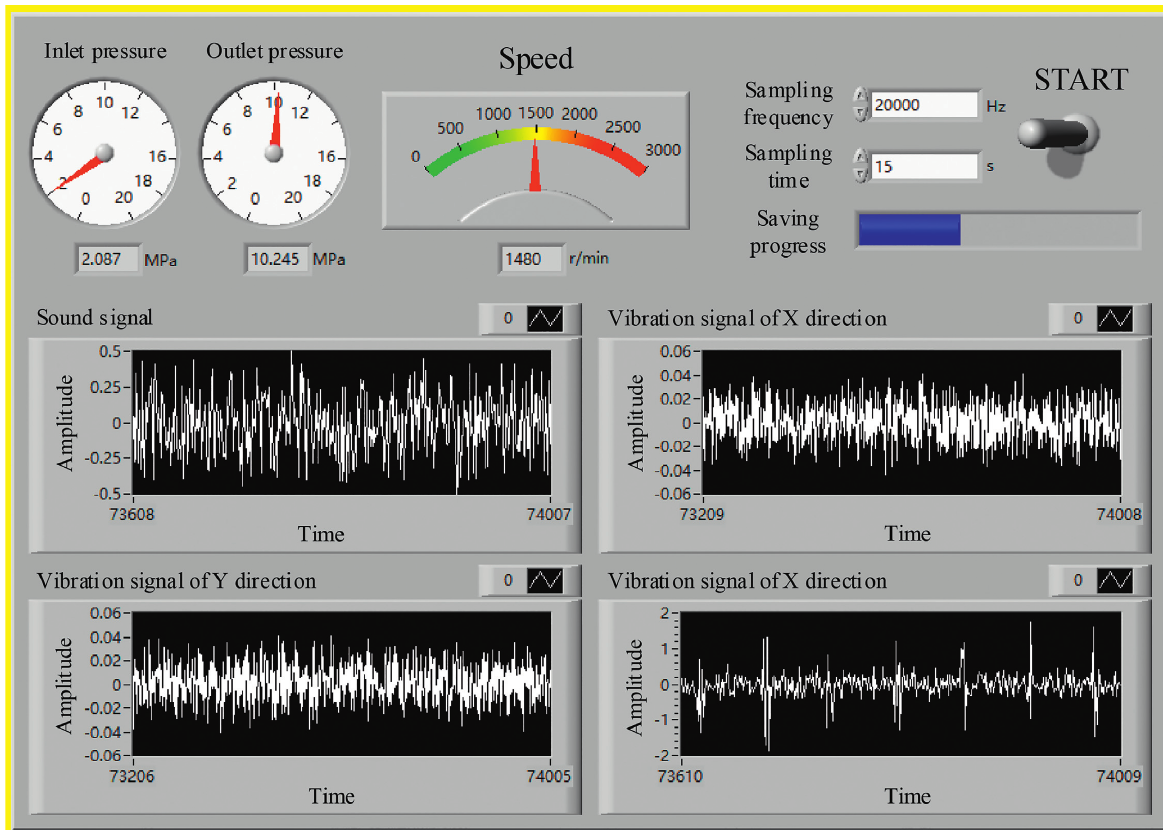
Figure 12: LabVIEW acquisition program front panel.